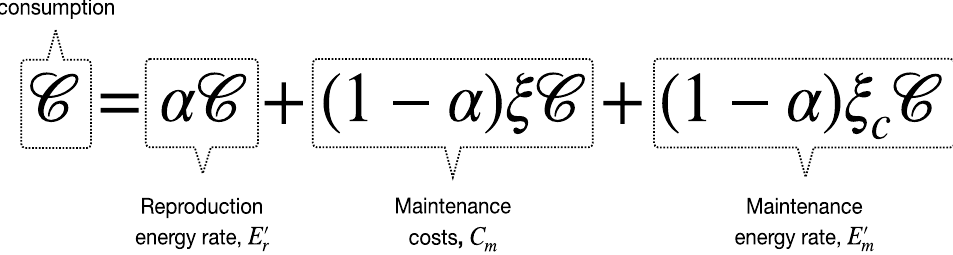
Figure 1. Relationships among individual consumption (per unit time), maintenance costs (per unit time), reproduction, and maintenance energy